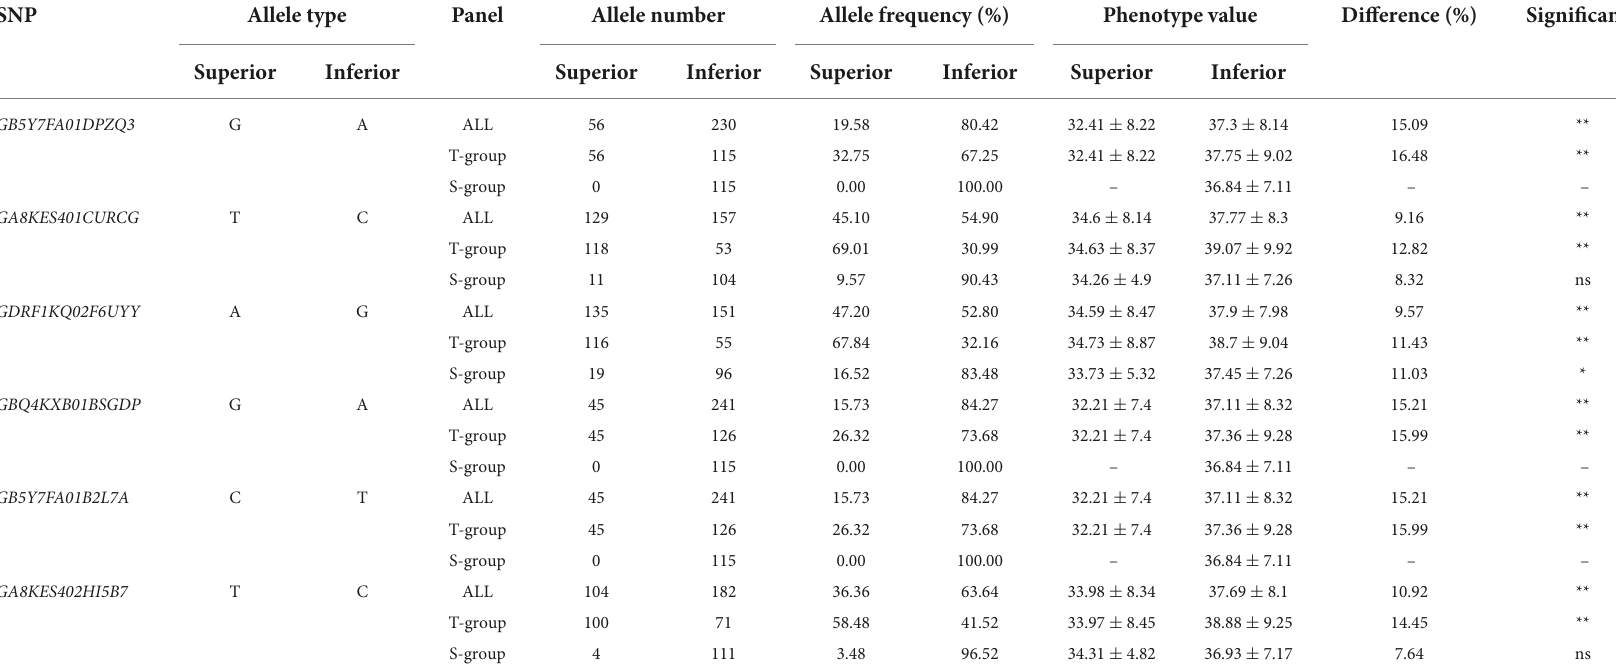
TABLE 4 Distributions of superior and inferior alleles for the six significant single nucleotide polymorphisms associated with Fusarium crown rot